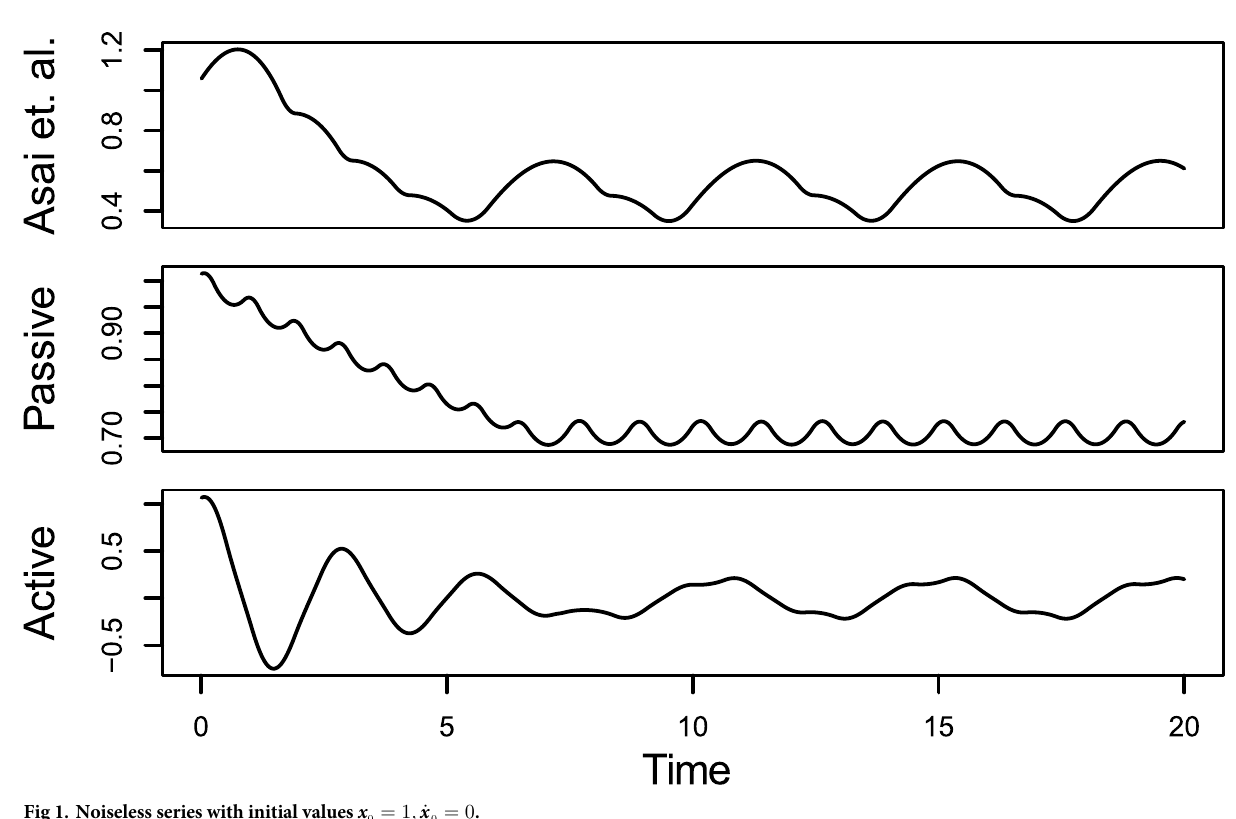
Fig 1. Noiseless series with initial values x